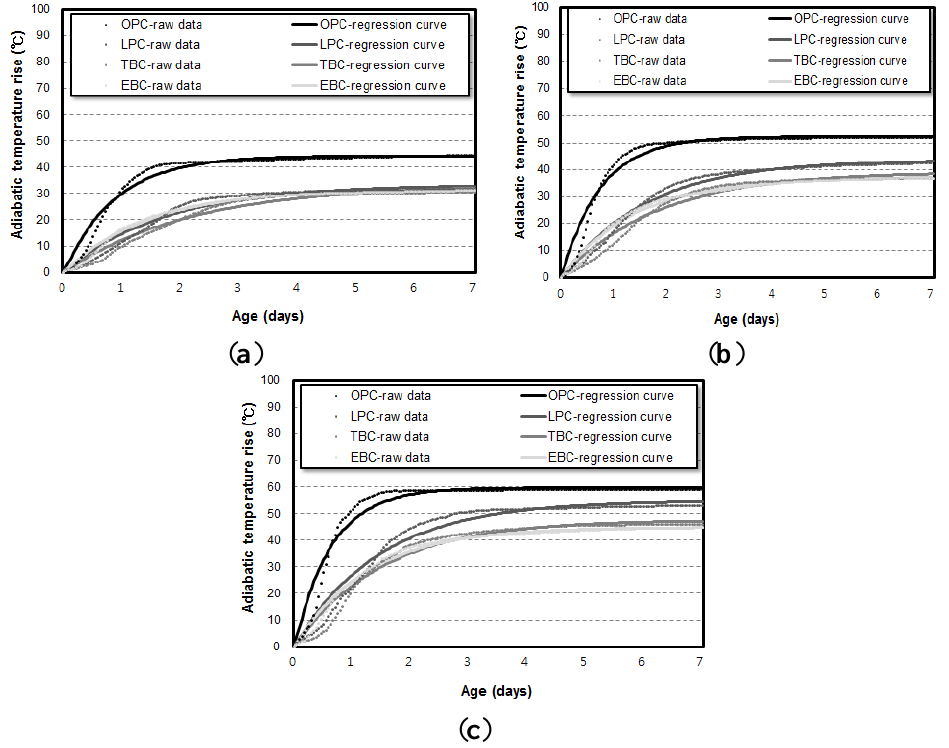
Figure 3. Results of the 50 L hadiabatic temperature rise test depending on binder types. ( a ) Unit weight of binder: 300 kg/m 3 ; ( b ) unit weight of binder: 400 kg/m 3 ; ( c ) unit weight of binder: 500 kg/m 3 .